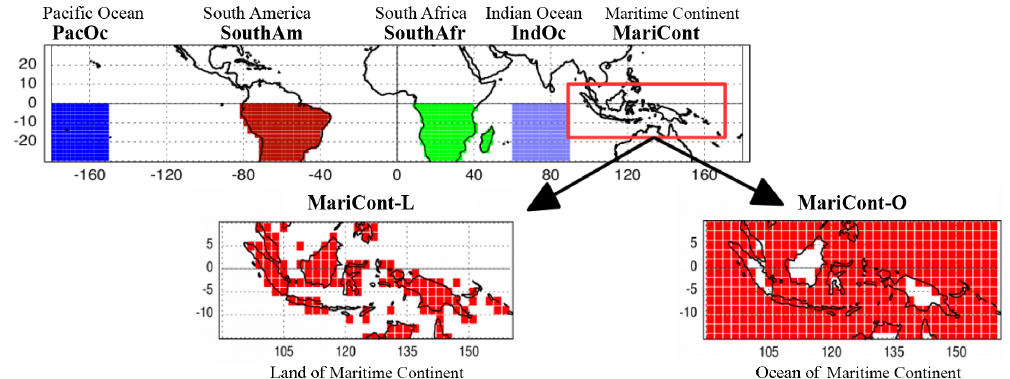
Figure 4. Representation of the study zones: PacOc, Pacific Ocean; SouthAm, South America; SouthAfr, South Africa; IndOc, Indian Ocean; MariCont-L, land of the Maritime Continent; and MariCont-O, ocean of the Maritime Continent. Each zone is defined at a horizontal resolution of 2 ◦ × 2 ◦ .